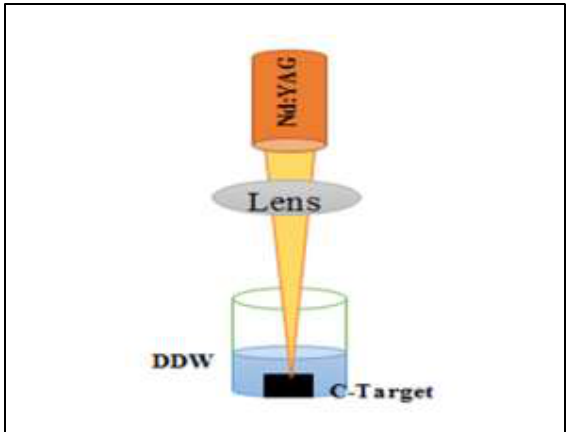
Fig.2: A schematic diagram of CNT-NPs preparation by the laser ablation in liquid technique.